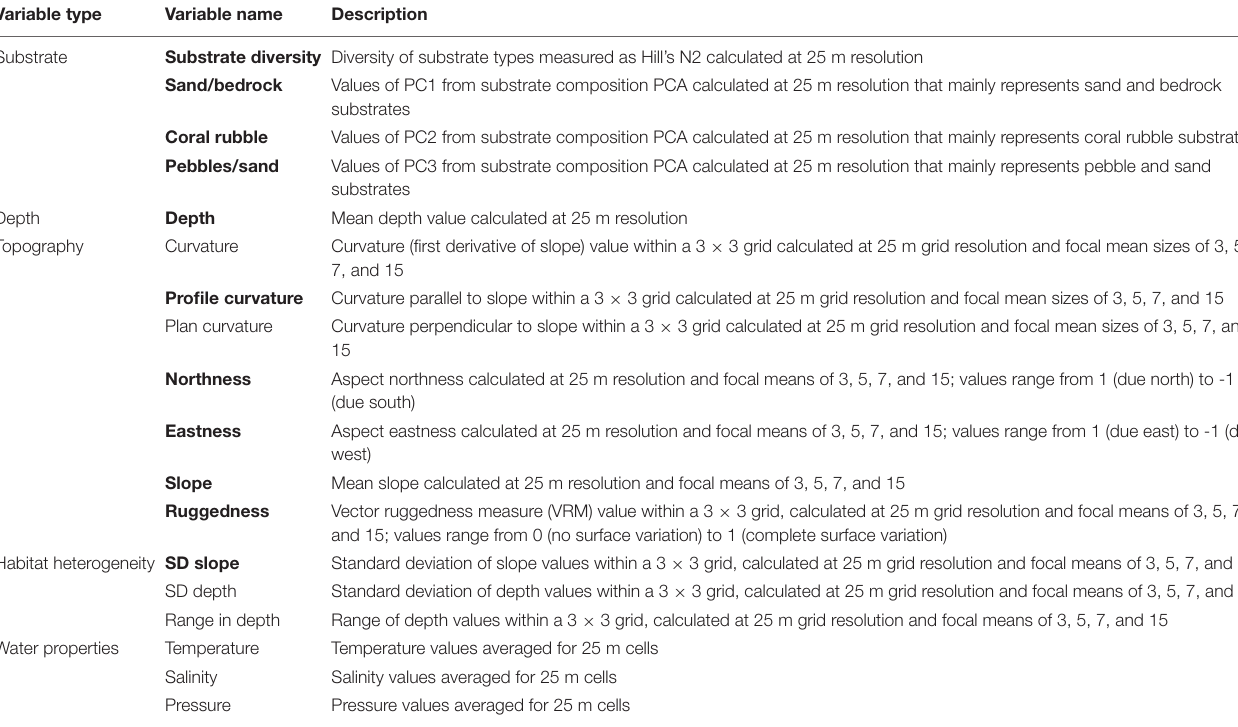
TABLE 1 | Descriptions of all environmental variables originally included for analysis prior to the removal of